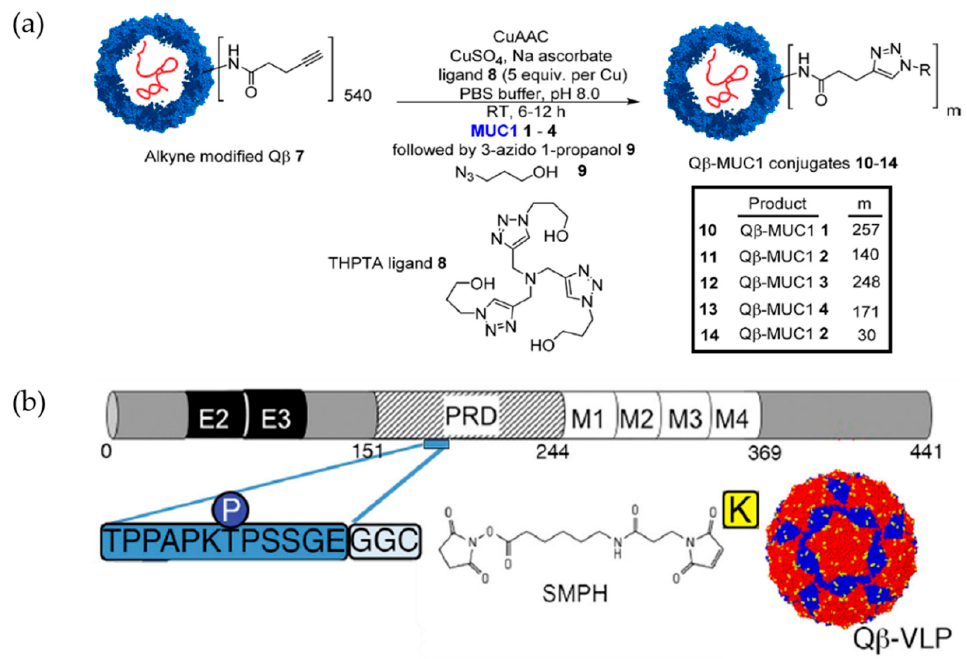
Figure 4. The utilization of Q β VLP as carrier in vaccine design strategies. ( a ) Scheme for the synthesis of Q β -MUC1 conjugates for tumor cell targeting. Reprinted with permission from [27]. Copyright (2018) American Chemical Society. ( b ) Conjugation of Q β VLP to pT181 for Alzheimer’s disease. Abbreviations: E, exon; PRD: protein rich domain; M: microtubule-binding domain. Reproduced with permission from Springer Nature (Creative Commons Attribution 4.0 International License)